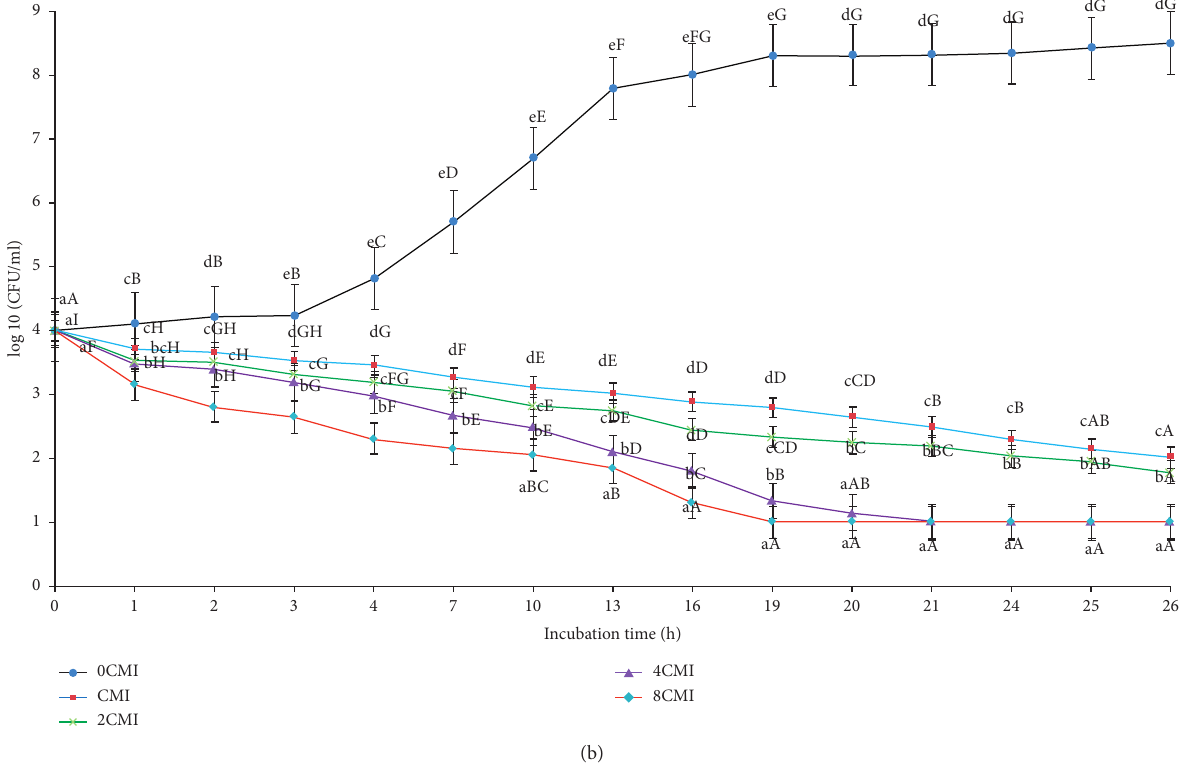
Figure 3: Influence of the dose of aqueous pistachio hull extracts on the growth of L. monocytogenes ATCC 19117 (a) and S. enterica ATCC 14028 (b) by using a linear model